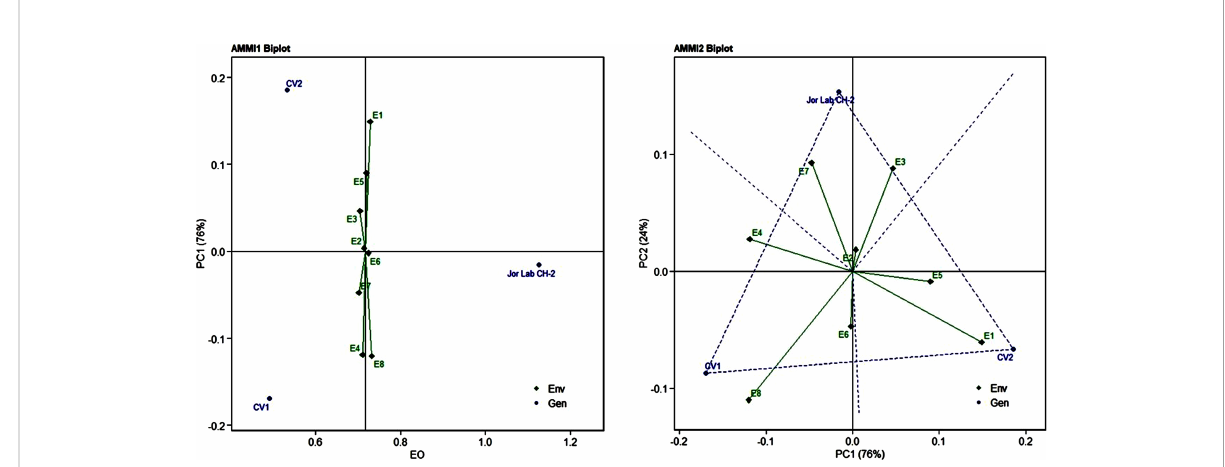
FIGURE 3 AMMI 1and2 model biplotforessentialoilyield(%)ofJorLabCH-2comparedwiththecheckgenotypes(CV1andCV2)evaluated ineight